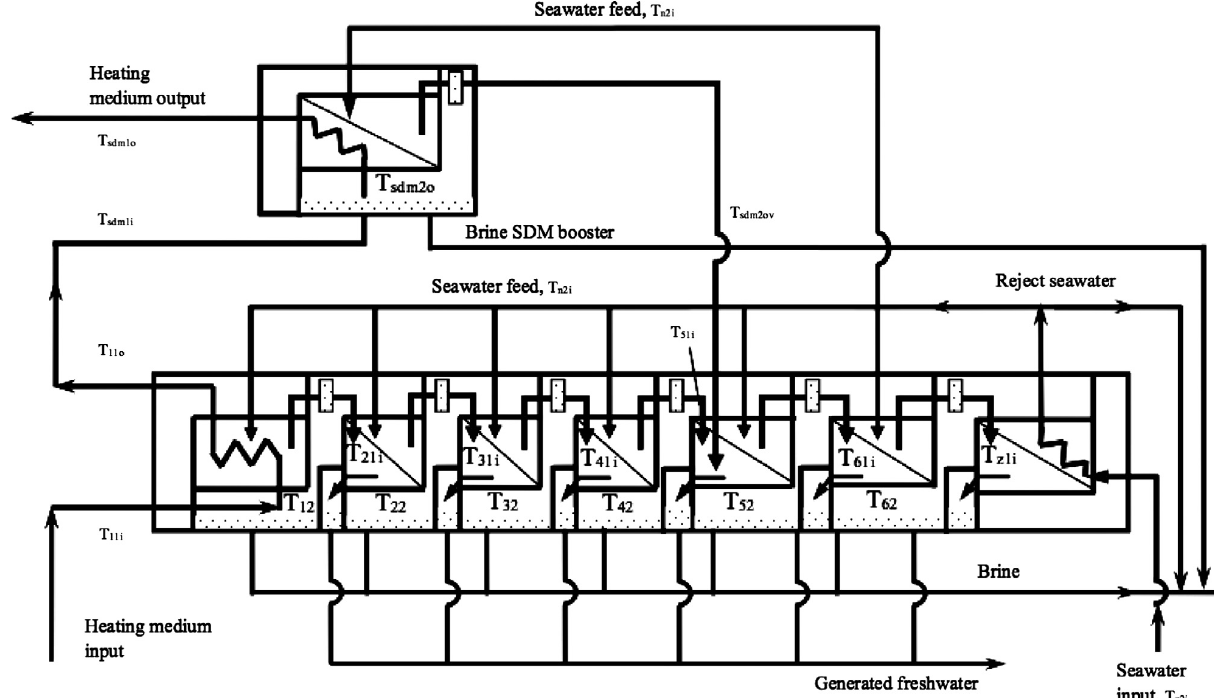
Figure 4. Schematic of the advanced multi-effect-distillation with single-effect-module booster [4].